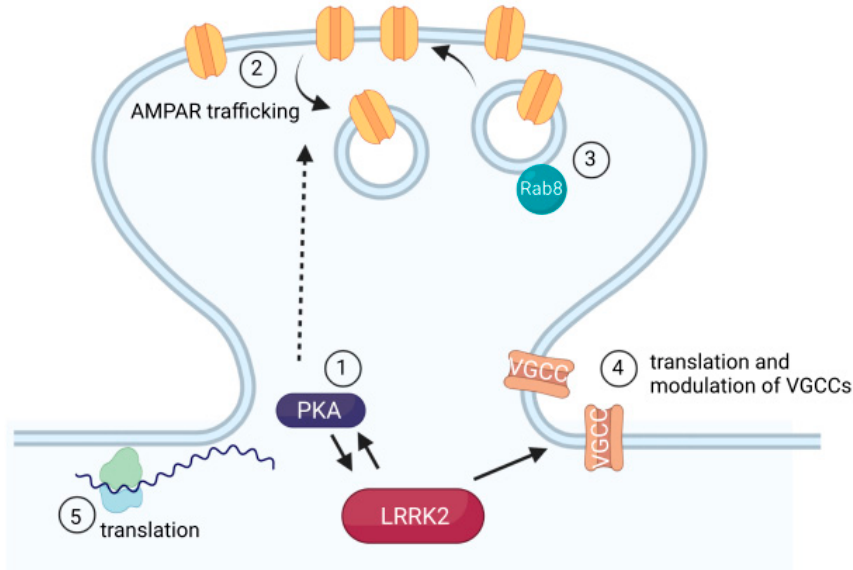
Figure 4. Effectors of LRRK2 postsynaptic function. Depiction of mechanisms by which LRRK2 affects synaptic function and downstream LRRK2 effectors that affect synapse function. (1) An interaction between the PKA PKARII β subunit and LRRK2 ROC domain acts as an AKAP, anchoring LRRK2 in dendritic shafts. The R1441C mutation impairs this interaction, resulting in increased translocation of PKA into dendritic spines. (2) Mutation- and cell-type-specific alteration of AMPAR trafficking in dendritic spines. The R1441C mutation increases GluR1 phosphorylation and AMPAR insertion into the membrane specifically in direct-pathway SPNs, increasing synapse strength. (3) The LRRK2 substrate Rab8 is essential for trafficking newly translated AMPARs to the synapse. (4) LRRK2 kinase activity modulates the translation (by affecting the efficiency with which ribosomes translate mRNAs with complex 5 ′ UTRs), and the function of voltage-gated calcium channels (VGCCs), resulting in increased calcium influx. (5) LRRK2 phosphorylates the ribosomal S15 subu- nit, promoting the increased translation of mRNAs. This figure was created using biorender.com.